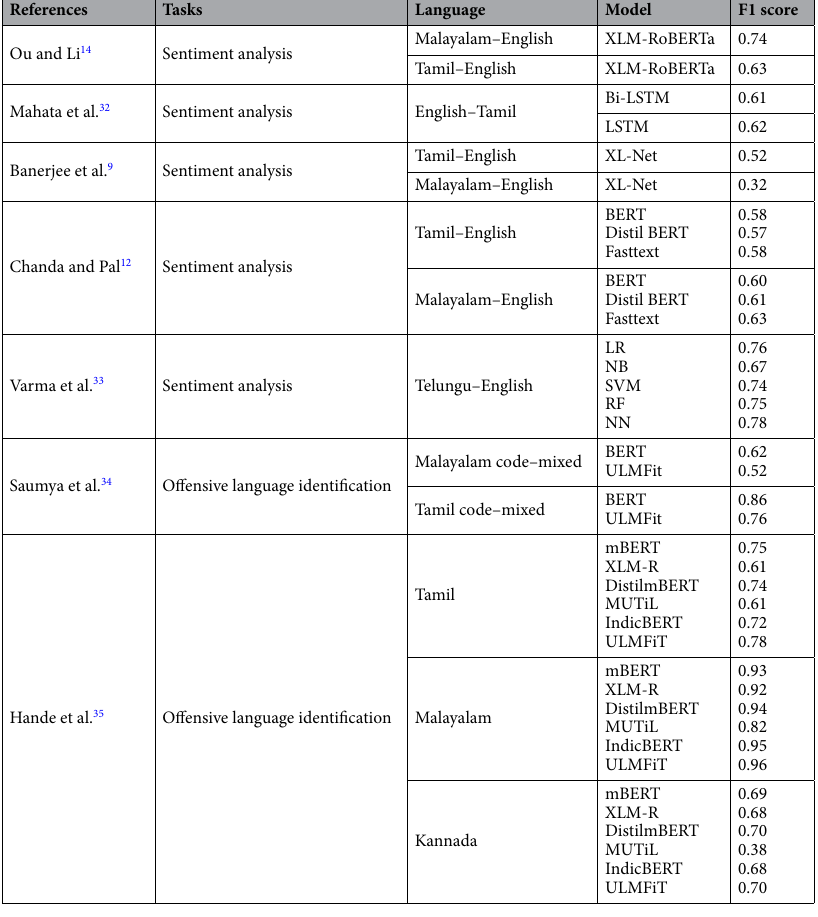
Table 1. Existing systems.